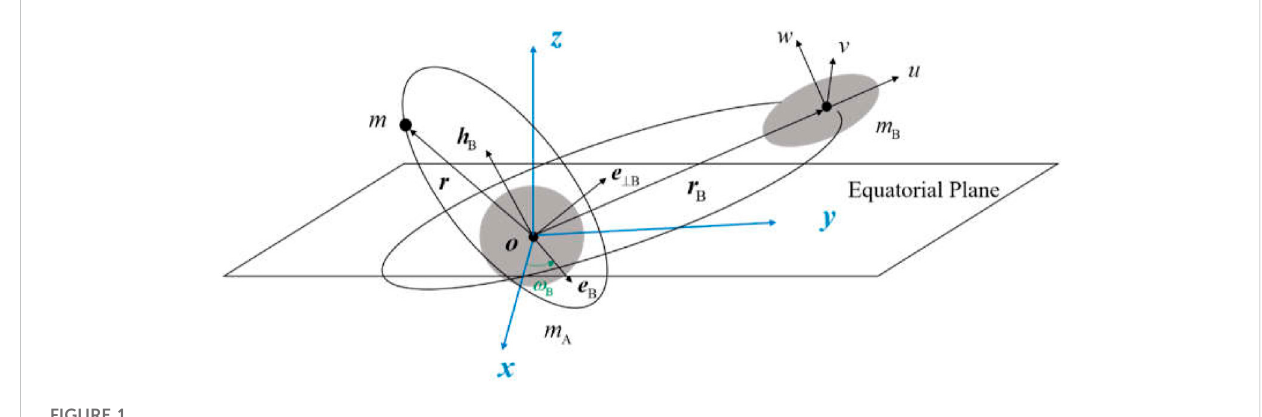
FIGURE 1 Geometry of the three-body